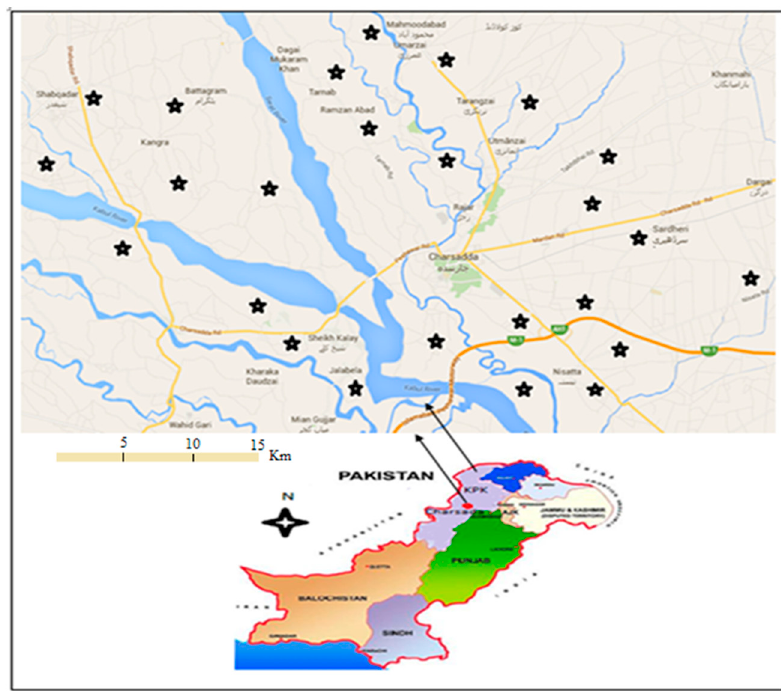
Figure 1. Map of Charsadda district locating various water sampling sites.